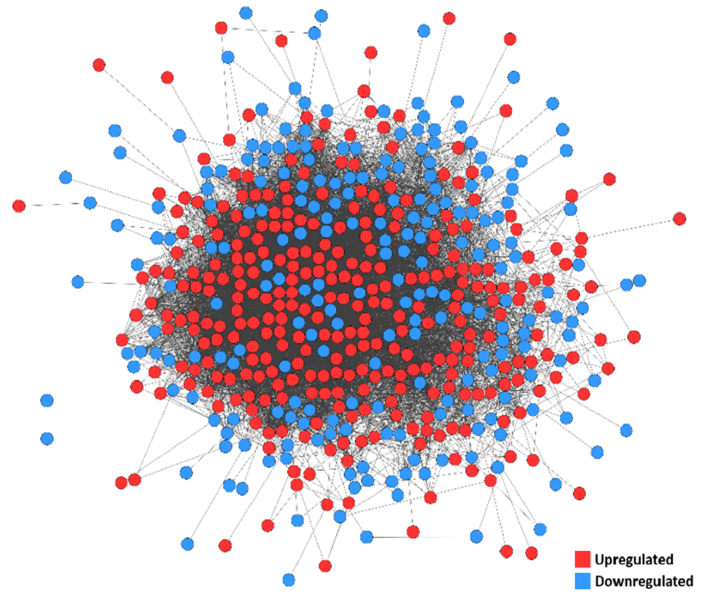
Figure 7. Protein–Protein Interaction (PPI) network of DEGs. Upregulated and downregulated DEGs are represented by red and blue nodes, respectively. Degree ≥ 1.